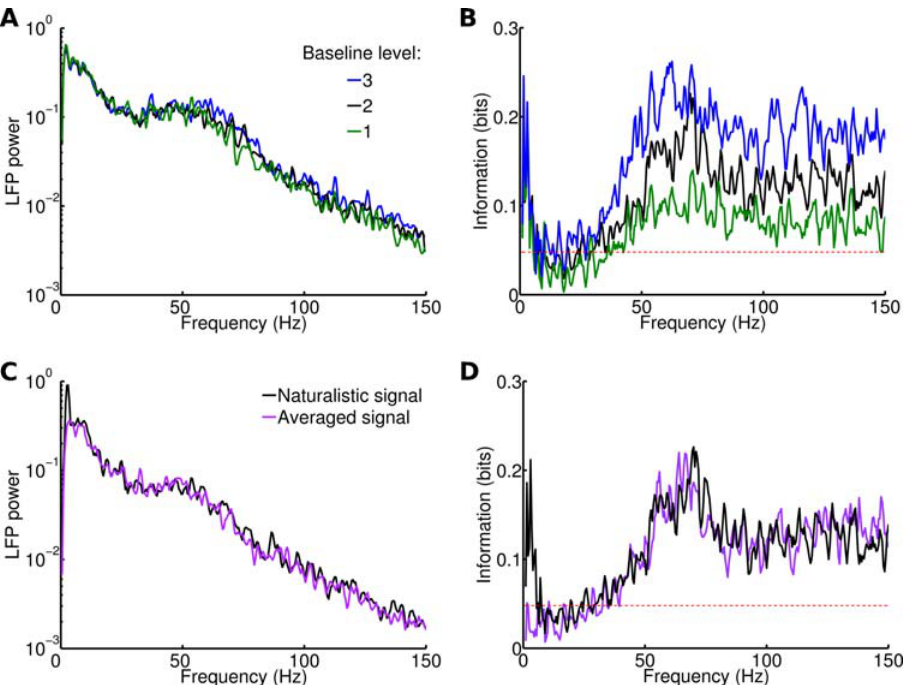
Figure 9. Effects of modulations of naturalistic stimuli. (A) Power spectrum of LFP during a single stimulus, for three different levels of baseline of the same signal. Results averaged over 20 trials. (B) Information content of LFP spectrum for three different levels of baseline for the whole input. Same color code as (A). Red dashed line corresponds to significance threshold (p , 0.05; bootstrap test) for information. (C) Power spectrum of LFP during a single stimulus with a naturalistic signal (in black) and with the same signal averaged (in purple). Results averaged over 20 trials. The stimulus selected is different from the one in (A). (D) Information contained in the LFP spectrum relative to naturalistic signals and averaged signals. Same color code as (C). Red dashed line same as (B).